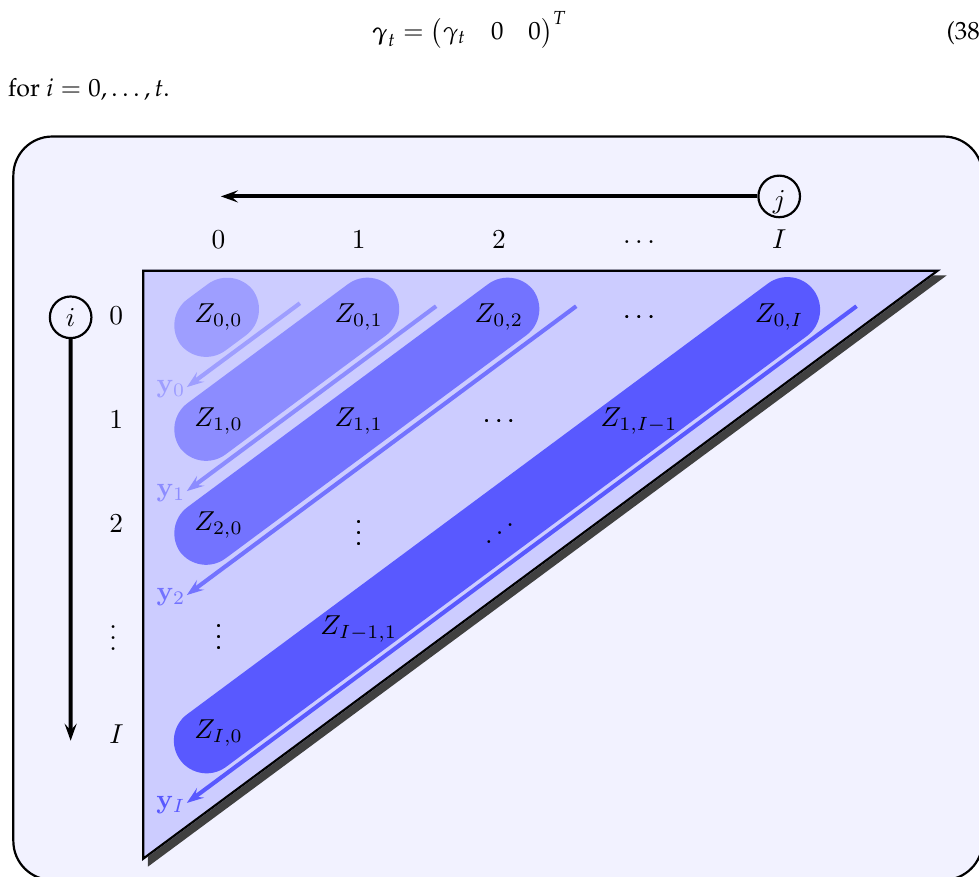
Figure 5. Calendar year-based modeling of the observation vector. While the state vector x i in the first modeling approach only contains the parameters of the i -th accident year, the state vector x t contains all parameters up to the t -th accident year plus the corresponding calendar year effect. This is due to the fact that the observations of the t -th calendar year pass through all accident years i = 0, . . . , t . The observation Equation (35) is thus given by     2, t 2 − . .